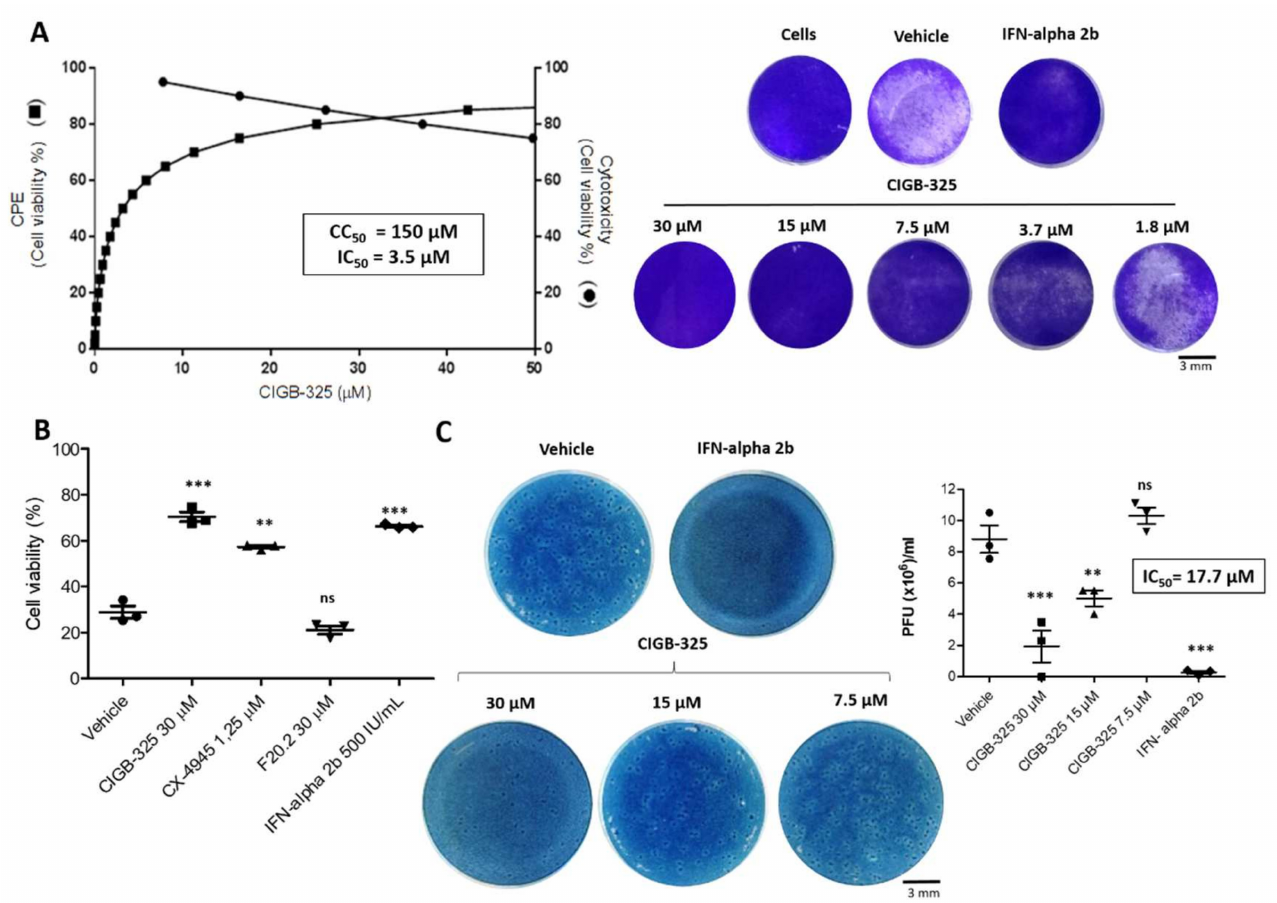
Figure 1. In vitro antiviral activity of CIGB-325 against BCoV-Mebus. MDBK cells were pre-treated with CIGB-325 at the indicated doses for 1h, and virus (14,000 TCID 50 /well) was then added to allow attachment for 1h. Subsequently, the cells were incubated in the presence of the indicated drug concentration for 4 days. ( A ) IC 50 (left axis) and CC 50 (right axis) were estimated from the fitted dose–response curves based on treatment with five CIGB-325 concentrations determined by cell viability assay (left section). Crystal violet stain wells for each experimental condition in the CPE inhibition assay (right section) scale bars: 3 mm. ( B ) Antiviral effect of positive (IFN-alpha2b, CX-4945) and negative controls (F20.2) was determined by cell viability assay using crystal violet stain. Cells were infected as previously described and incubated with CIGB-325 (30 µ M), F20.2 (30 µ M), CX-4945 (1.25 µ M), and IFN-alpha2b (500 IU). Uninfected cells with the vehicle were set to 100%. C. Progeny titers of the cell culture supernatants collected from CPE inhibition experiments were assessed using plaque assay. Data from ( B , C ) are shown as mean ± SD, n = 3. Statistically significant differences between vehicle and drug treatment are represented as ** p < 0.01, *** p < 0.001 and ns, not significant determined using one-way ANOVA followed Dunnett